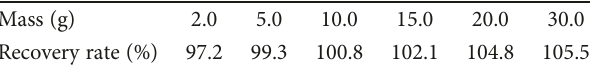
Table 1: Results of di ff erent